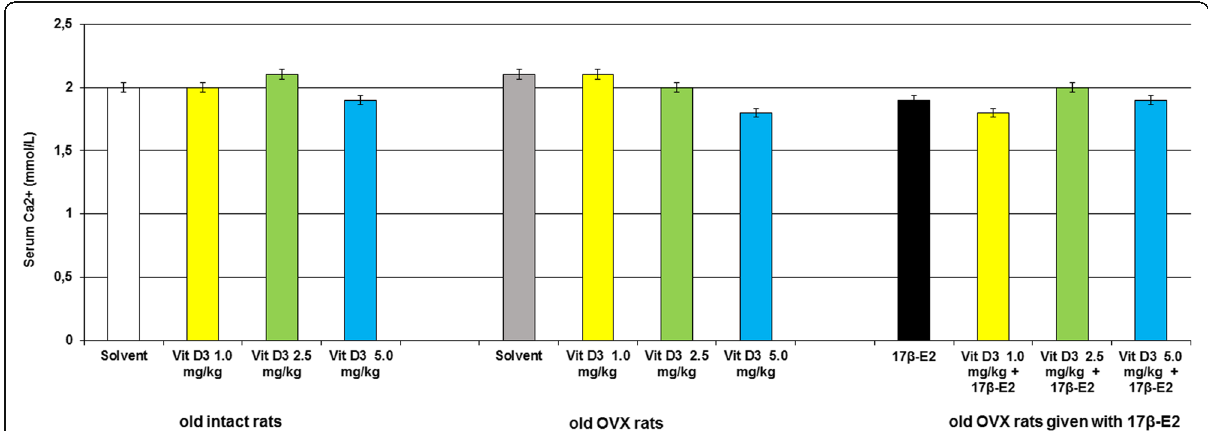
Fig. 5 Effects of Vitamin D 3 administration on calcium level of the old ovariectomized (OVX) rats following long-term estrogen deficiency in the serum blood. The obtained results show the mean ± standard error of the mean (SEM). * – p < 0.05 as compared to the control group of the old sham-operated rats; # – p < 0.05 as compared to the old OVX rats treated with solvent; $ – p < 0.05 as compared to the old OVX rats treated with 17 β -estradiol (17 β -E 2 ). Each group comprised a minimum of eight rats. Cholecalciferol was given at 1.0, 2.5 or 5.0 mg/kg/daysubcutaneously (s.c.), once daily, for 14 days. The administered dose of 17 β -estradiol was 0.5 μ g/rat s.c., once daily, for 14